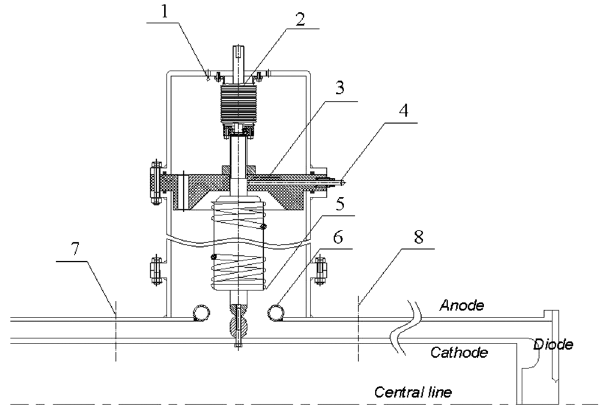
FIG. 6. Extensional MITL with high inductive helical support and diode load. B-dot (1) is used to record current of helical inductor. By changing the length of corrugated pipe (2), con- necting and disconnecting of inductor (5) to ground are realized. A nylon insulation plate (3) helps to radially positioning the inductor. Grading structure (6) prevents electron drift into the inductor tube. Copper rod (4), inductor (5), and inner electrode of the MITL form current passage for premagnetizing pulse. Line (7) and line (8) denote cross sections where upstream and downstream current probes